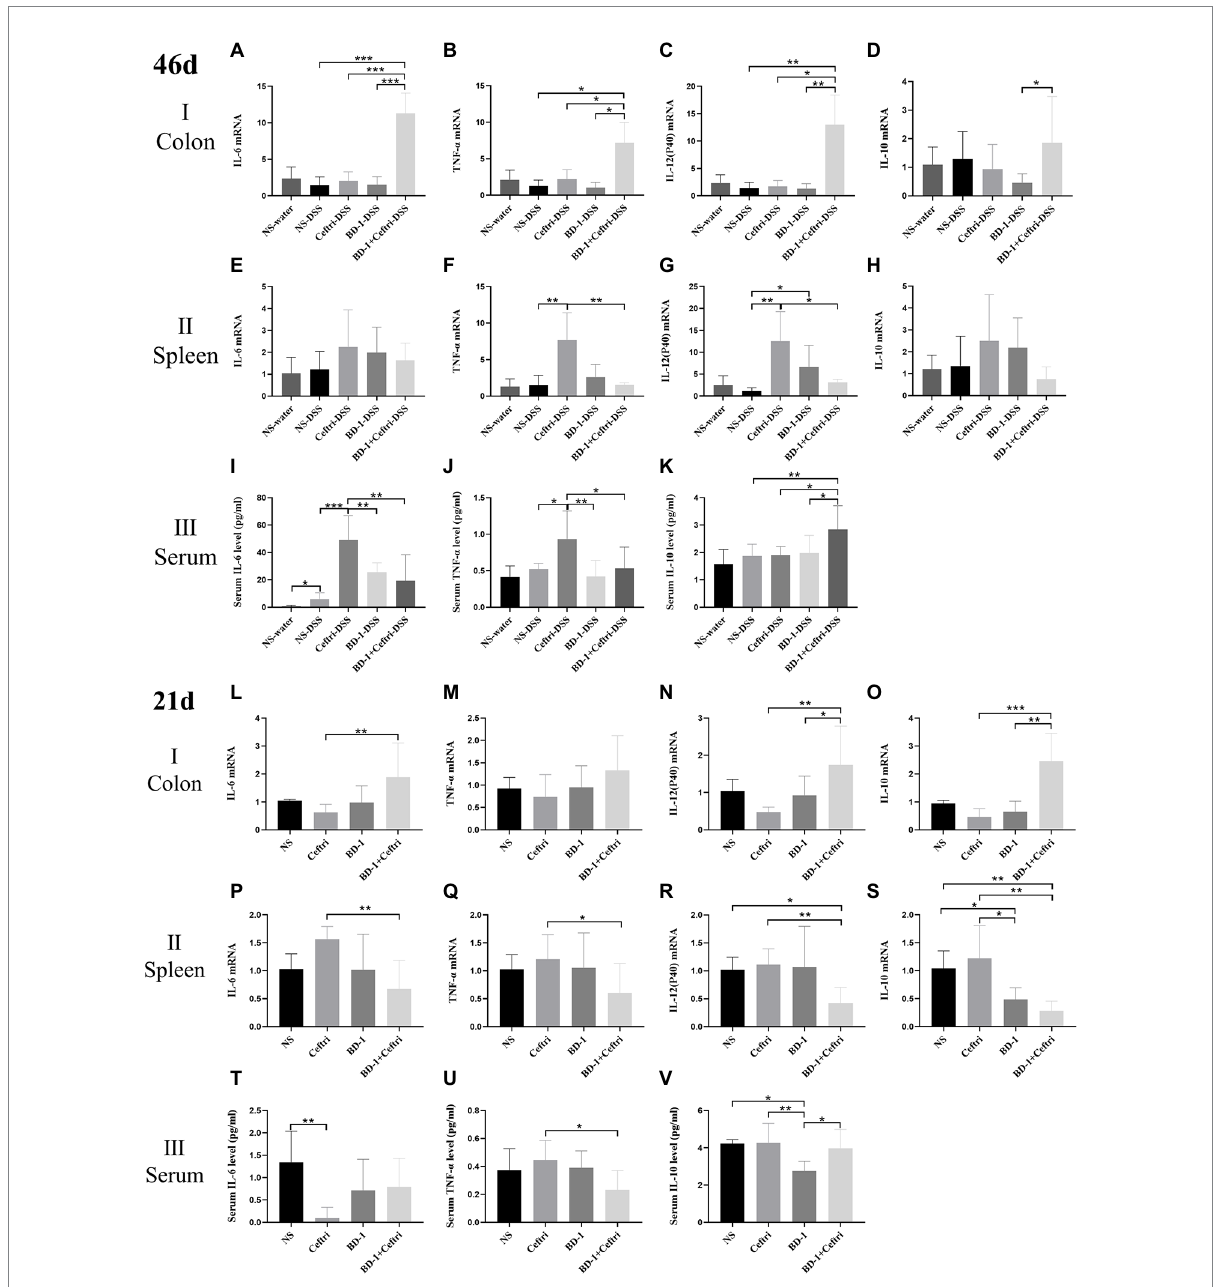
FIGURE 3 Local and systemic immunity after DSS induction and early life intervention (46 and 21 days, respectively; n = 6). (A–K) on day 46 and (L–V) on day 21. (A) Colonic IL-6 mRNA level. (B) Colonic TNF- α mRNA level. (C) Colonic IL-12 (P40) mRNA level. (D) Colonic IL-10 mRNA level. (E) Splenic IL-6 mRNA level. (F) Splenic TNF- α mRNA level. (G) Splenic IL-12(P40) mRNA level. (H) Splenic IL-10 mRNA level. (I) Serum IL-6 level. (J) Serum TNF- α level. (K) Serum IL-10 level. (L) Colonic IL-6 mRNA level. (M) Colonic TNF- α mRNA level. (N) Colonic IL-12(P40) mRNA level. (O) Colonic IL-10 mRNA level. (P) Splenic IL-6 mRNA level. (Q) Splenic TNF- α mRNA level. (R) Splenic IL-12 (P40) mRNA level. (S) Splenic IL-10 mRNA level. (D) Serum IL-6 level. (U) Serum TNF- α level. (V) Serum IL-10 level. * p < 0.05, ** p < 0.01, and *** p < 0.001 as